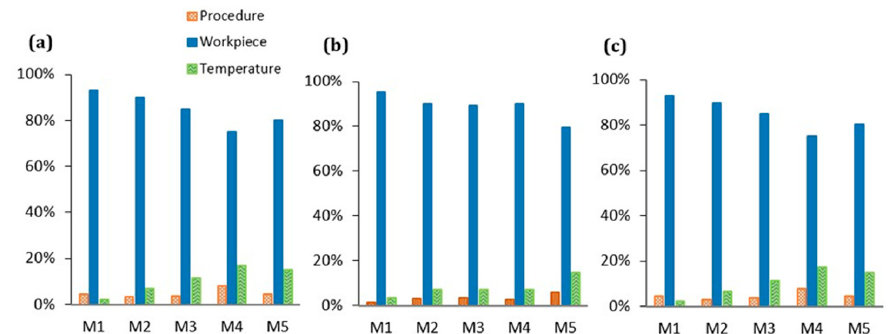
Figure 13. Percentage of each uncertainty component respect to the total uncertainty for the SLS ( a ), PSSRT, ( b ) and LLS ( c ), considering the unidirectional lengths.